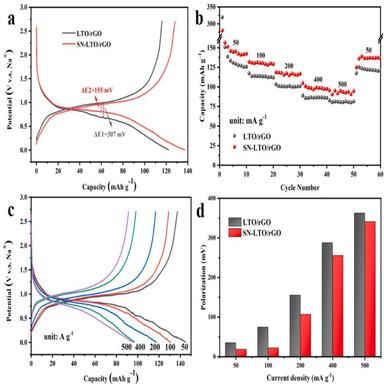
(a) Typical charge and discharge profiles of LTO/rGO and SN-LTO/rGO electrodes at a current density of 100 mA g−1; (b) Rate capacity of LTO/rGO and SN-LTO/rGO electrodes at different current densities; (c) Charge and discharge profiles of SN-LTO/rGO electrodes at different current densities; (d) Polarization voltage of LTO/rGO and SN-LTO/rGO electrodes at different current densities.